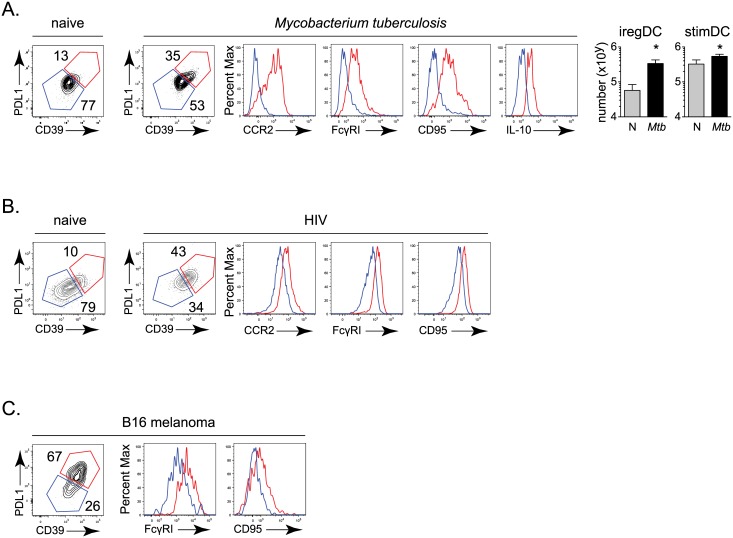
Monocyte-derived iregDCs develop in Mtb infection, HIV infection and cancer.
A. Flow plots show CD39 and PDL1 expression on splenic CD11b+ DCs from IL-10 reporter mice either uninfected or infected with virulent Mtb for 36 days. Histograms indicate expression of the indicated protein on iregDC (red) and stimDC (blue). Bar graphs indicate the number of iregDC and stimDC in uninfected and Mtb infected mice. B. Flow plots show CD39, PDL1 and monocyte-associated proteins on CD11c++, HLA-DR+, CD14+ iregDC (red) and stimDC (blue) from the peripheral blood of naïve humanized mice and HIV infected humanized mice. C. Flow plots show CD39, PDL1 and monocyte-associated proteins on CD11b+, CD11c++ iregDC (red) and stimDC (blue) on B16 melanoma infiltrating leukocytes. Data are representative of 2 or more independent experiments each consisting of 4–7 mice per group. *, p<0.05.